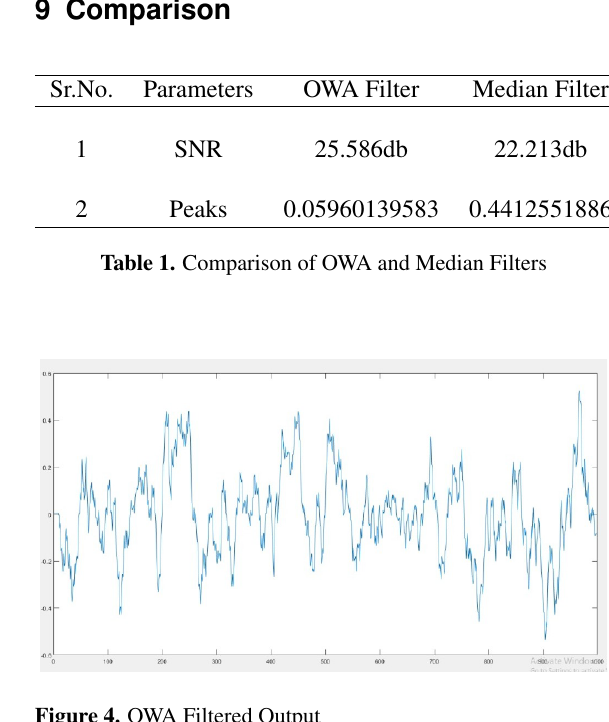
Figure 4. OWA Filtered